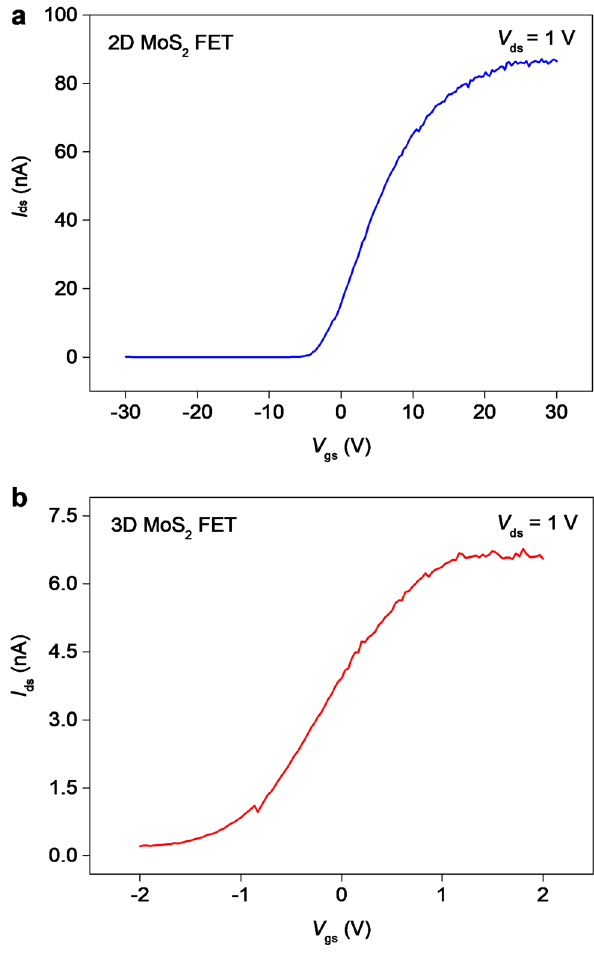
Figure 2: Electrical properties of MoS 2 FETs. (a) Ideal transfer characteristic of 2D MoS 2 FET; (b) transfer characteristic of 3D MoS 2 FET. 2D, two-dimensional; 3D, three- dimensional; FET, fi eld-effect transistor; MoS 2 , molybdenum disul fi